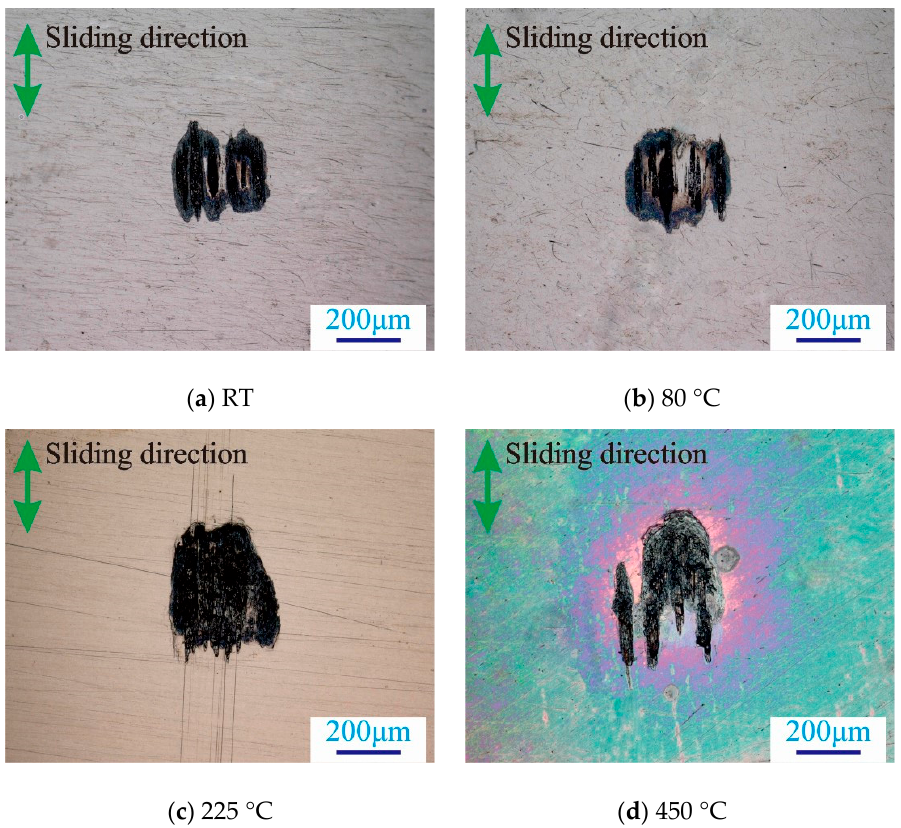
Figure 4. Super depth field micrographs of worn scars at varied temperatures: F = 20 N, D = 50 μ m.